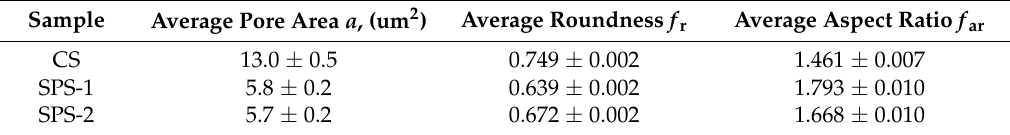
Table 5. Parameters of porosity.